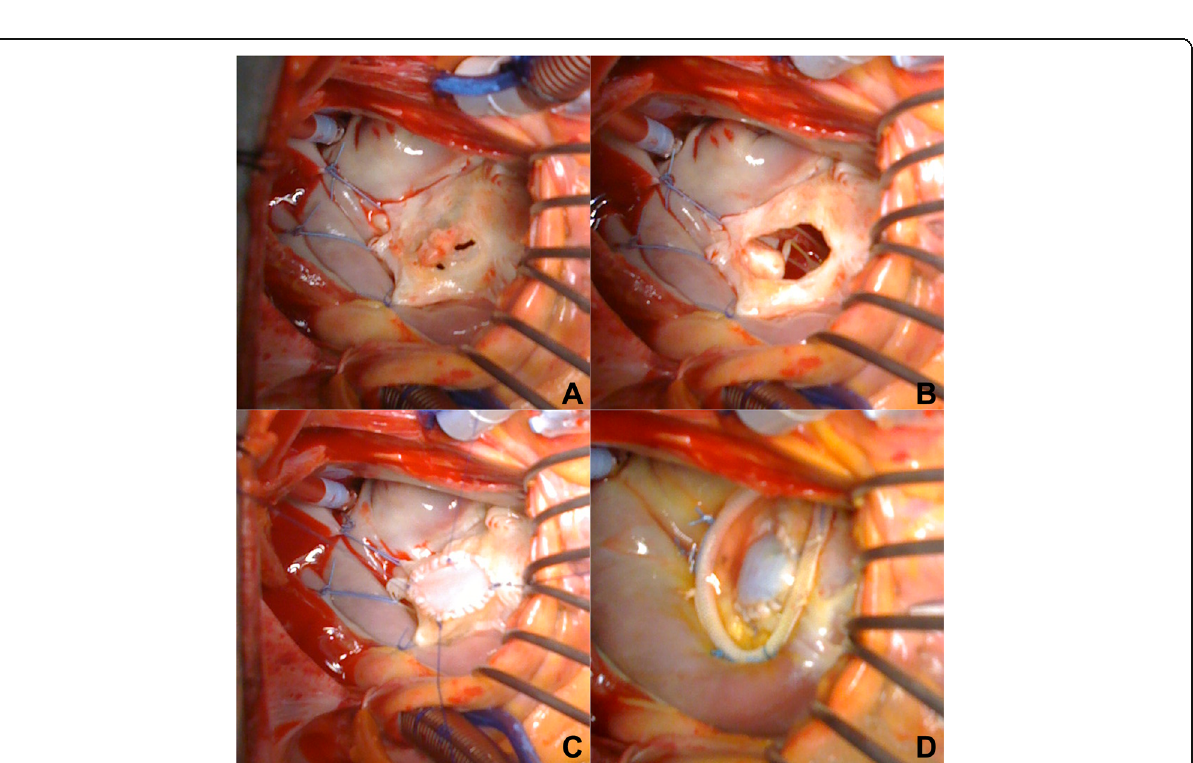
Fig. 3 Mitral endocarditis with perforation of the anterior leaflet. a , b After careful debridement and removal of the infected tissue, a large hole is left in the body of the anterior mitral leaflet. The perforation is repaired with an appropriate size fresh autologous pericardial patch ( c ). The final test with saline demonstrates a perfectly competent mitral valve ( d